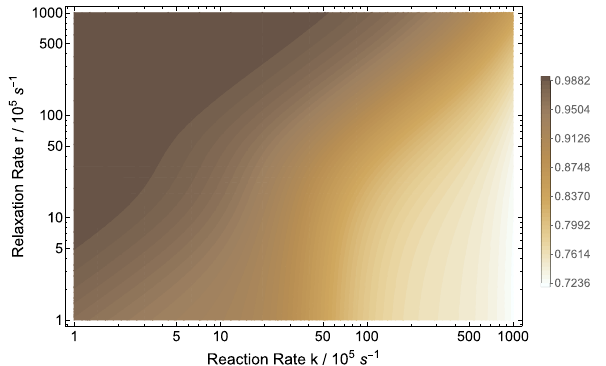
Figure 5. The RPM model prediction of the MT density ratio of the administration of Zn (with zero nuclear spin) over 67 Zn (with nuclear spin of I B = − 5 2 ) based on the RP complex of [ TrpH . + . . . O2 . − ]. 67 Zn The geomagnetic field has a strength of 0.05 mT. 67 Zn ’s nuclear spin modulates rate k p for a A = 1.6046 mT and a B = − 11.39 mT.